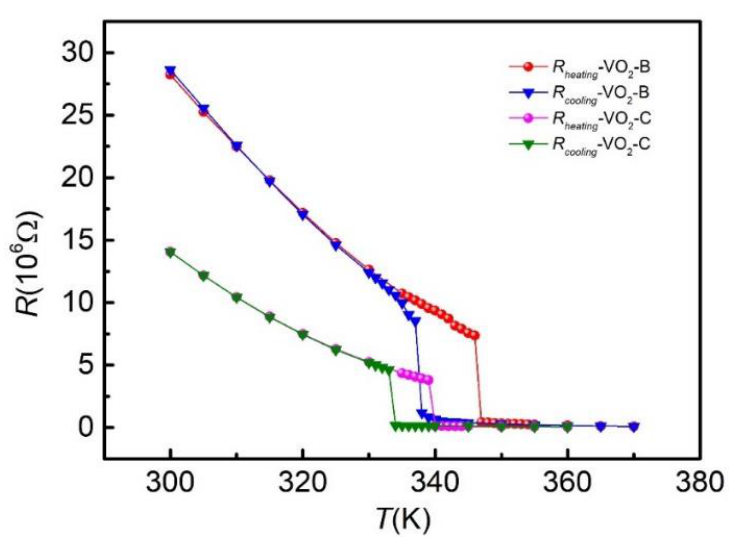
Figure 3. The electrical resistance as a function of temperature for VO 2 -B and VO 2 -C, respectively. To further analyze the underlying mechanisms, we studied the contribution of elec- tronic thermal conductivity using the Wiedemann − Franz law: κ e = σ LT , where κ e , σ , L and T are electronic thermal conductivity, electronic conductivity, Lorenz number and temperature of samples, respectively. Figure 4 shows the thermal conductivity as a func- tion of temperature, where κ p and κ were phonon thermal conductivity and measured total thermal conductivity, respectively. κ p is determined by subtracting the κ e from κ . It is evident that κ e increases as the temperature rises over the entire temperature range. Remarkably, κ e increased by two orders of magnitude near the phase transition point. However, the contribution of κ e to κ was negligible, not exceeding 4%, no matter whether Wiedemann − Franz law was valid or not, as proposed previously [34]. κ p decreased with the increasing temperature under the phase transition temperature. Above the phase transition temperature, the trend of temperature-dependence on thermal conductivity was reversed, i.e., κ p gradually increased. The trend of κ p was consistent with that of κ , indicating that the reason behind the jump of κ mainly comes from the contribution of